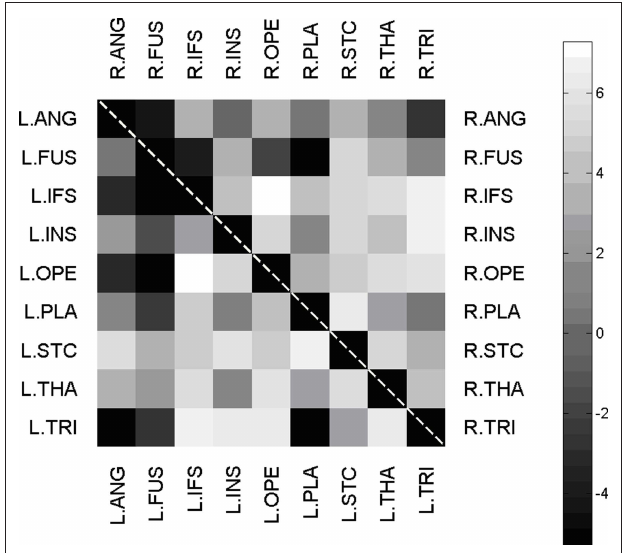
FiguRe 3 | Connectivity matrix. Matrix of connectivity between all intra-hemispherical pairs of n = 18 ROIs. Pairs within left-hemisphere are displayed in the lower left half, pairs within right-hemisphere in the upper right half. All connectivity strengths are displayed with a logarithmic grayscale